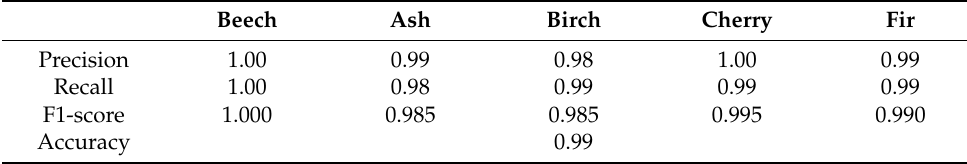
Table 4. Prediction Matrix of AM-SPPResNet + SVM on Test